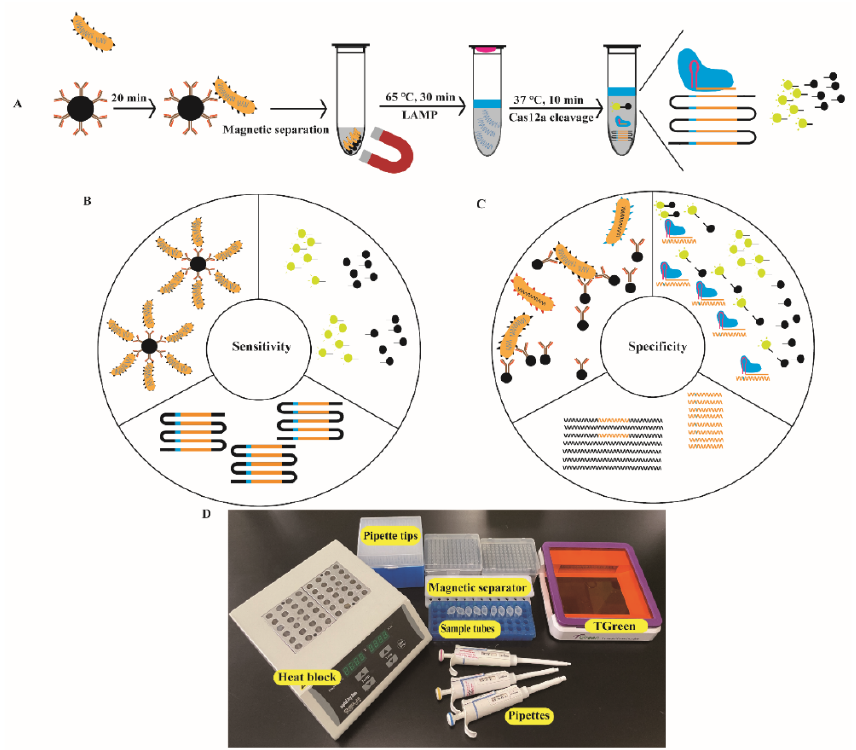
Figure 1. Design and working principle of the ICB-LAMP-CRISPR/Cas12a method. ( A ) Schematic of the ICB-LAMP-CRISPR/Cas12a method. Campylobacter jejuni was captured by the prepared ICB and separated magnetically. Five microliters of template DNA of C. jejuni was added to the LAMP mixture, which was placed at the bottom of the tube and sealed with 20 μ L of mineral oil. The CRISPR/Cas12a reaction reagents are added inside the lid. After 30 min of LAMP amplification at 65 °C, the tube was shaken to mix with Cas12a reagents for cleavage. Once the Cas12a nuclease is activated by recognizing the DNA target, it splits the quenched fluorescent ssDNA-FQ probe indis- criminately, generating a fluorescence signal visible to the naked eye under blue light. ( B ) Enhanced sensitivity of the ICB-LAMP-CRISPR/Cas12a method. The sensitivity was enhanced in three parts: the enrichment of ICB, the high efficiency of LAMP amplification, and the indiscriminate cleavage of the fluorescent ssDNA-FQ probe. ( C ) Enhanced specificity of the ICB-LAMP-CRISPR/Cas12a method. The specificity was enhanced from three parts: the specific antibodies of C. jejuni coated in the magnetic beads, the LAMP primers designed based on the conserved hipO gene, and the cleav- age activity of Cas12a guide by the specific sgRNA. ( D ) Work conditions of the nearly instrument- free POC diagnostics. Equipment and consumables needed for running the ICB-LAMP- CRISPR/Cas12a method include a heat block, pipettes, pipette tips, sample tubes, and T-green trans-